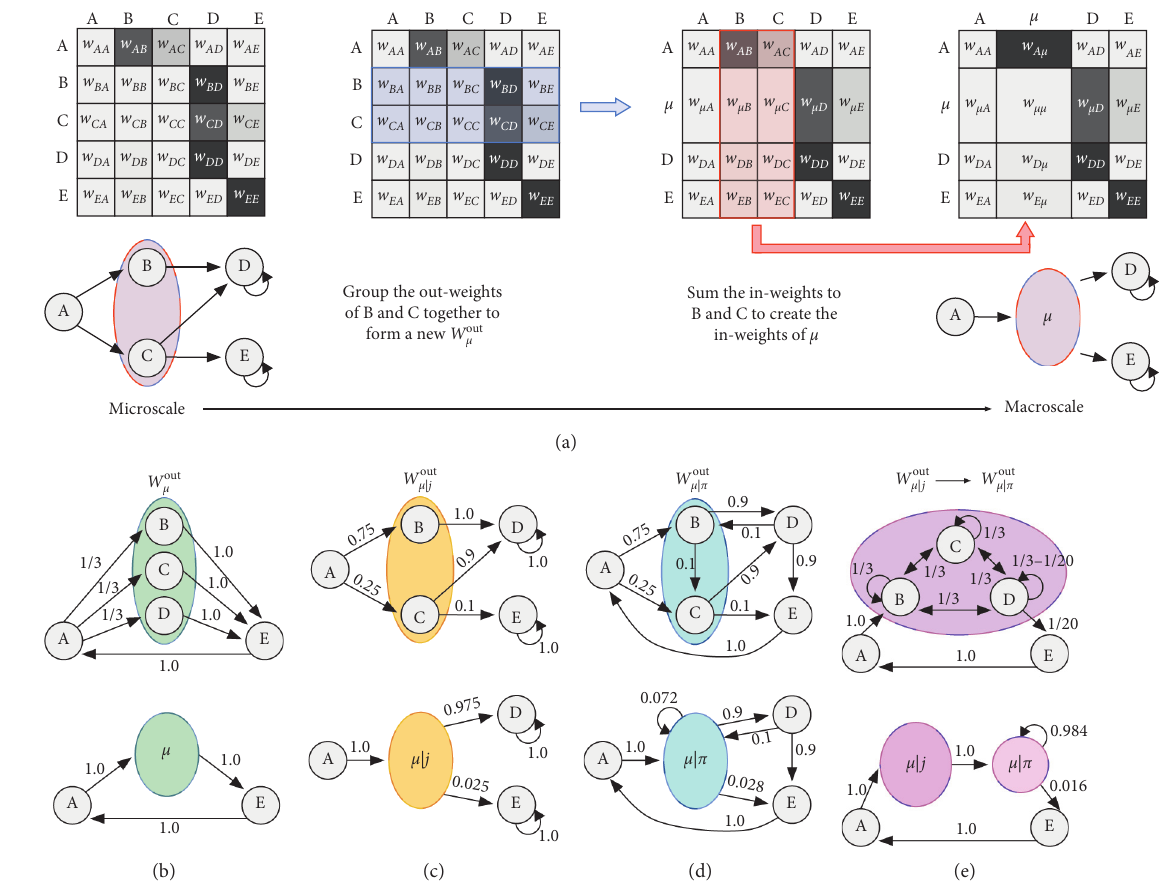
Figure 4: Macronodes. (a) The original network, G along with its adjacency matrix (left). The shaded oval indicates that subgraph S member nodes v B and v C will be grouped together, forming a macronode, μ . All macronodes are some transformation of the original adjacency matrix via recasting it as a new adjacency matrix (right). The manner of this recasting depends on the type of macronode. (b) The simplest form of a macronode is when W out is an average of the W out i of each node in the subgraph. (c) A macronode that represents some path- μ , the out-weights of nodes v B and v C are weighted by their input from dependency, such as input from A . Here, in averaging to create the W out μ v A . (d) A macronode that represents the subgraph’s output over the network’s stationary dynamics. Each node has some associated π i , which of a μ | π macronode is created by weighting each W out i of the is the probability of v i in the stationary distribution of the network. The W out μ micronodes in the subgraph S by ( π i / 􏽐 k π k ) . (e) A macronode with a single timestep delay between input μ | j and its output μ | π , each ∈ S constructed using the same techniques as its components. However, μ | j always deterministically outputs to μ | π . See SM VA for the full equations governing the creation of the W out of each of the different HOMs μ